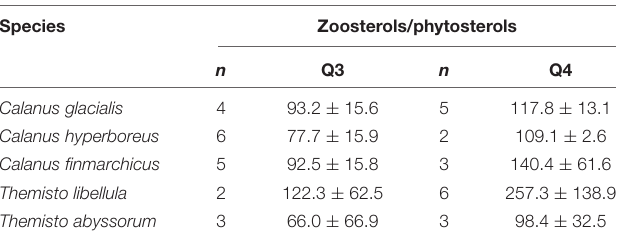
TABLE 4 | Ratios of the relative values of zoosterols/phytosterols (mean ± SD) in copepods and amphipods during summer (Q3) and winter (Q4).